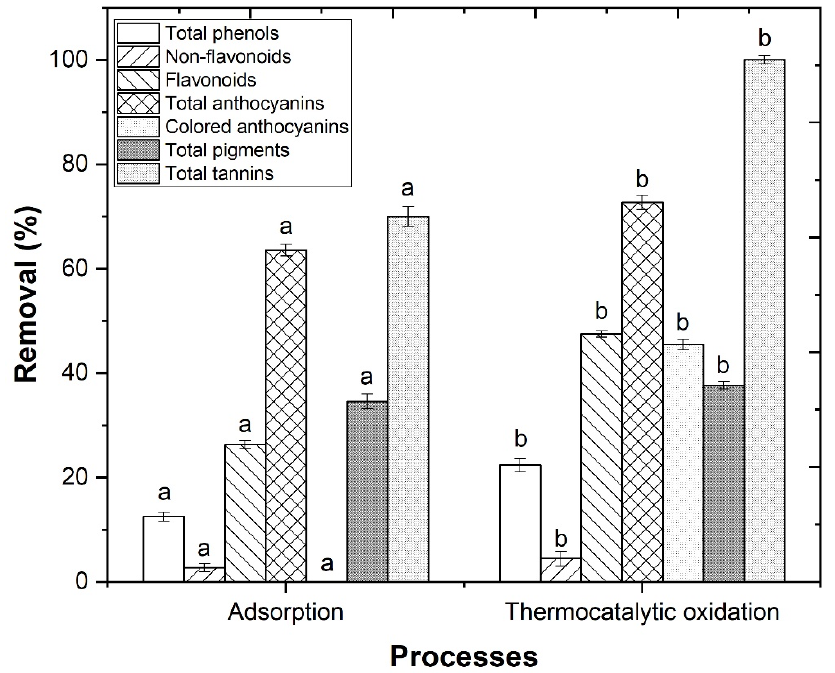
Figure 11. Analysis of phenolic composition after adsorption process and combined adsorption- thermocatalytic oxidation processes. Adsorption operational conditions, as follows: [Na-Mt] = 5.0 g/L, pH = 3.0, V = 500 mL, agitation 350 rpm, T = 298 K, t = 24 h. Thermocatalytic oxidation conditions, as follows: S 2 O 2 − /H 2 O 2 ratio = 1:0.25, S 2 O 2 − /H 2 O 2 dosage = 0.1:0.025 ( g / g ), pH = 7.0, T = 343 K, agitation 8 8 350 rpm, t = 2 h. Means in bars with different letters represent significant differences ( p < 0.05) between each parameter (total phenols, non-flavonoids, flavonoids, total anthocyanins, colored anthocyanins, total pigments and total tannins) by comparing